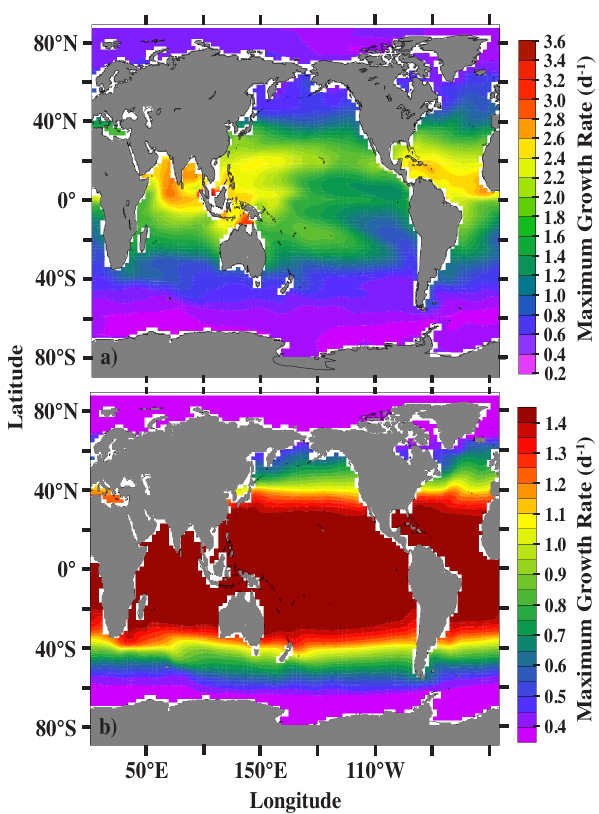
Fig. 2. Annual surface layer maximum potential growth rates of (a) phytoplankton ( P O ) and (b) zooplankton ( Z) .